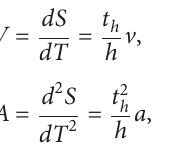
Figure 11: Working space for the varus/valgus